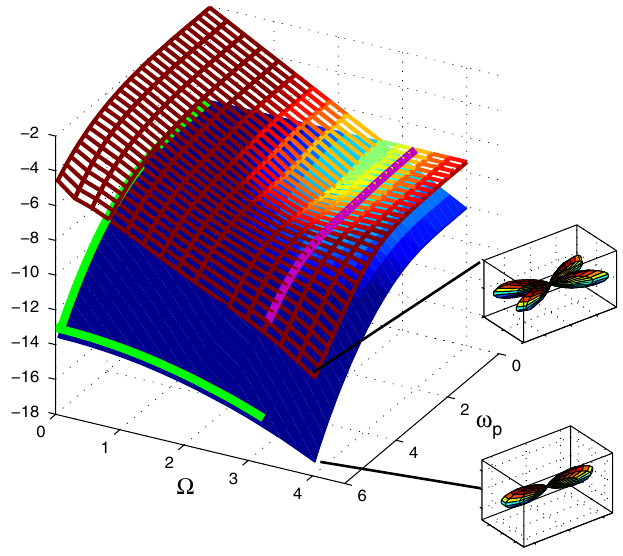
FIG. 5. Energy eignvalues of the rotating frame Hamiltonian, ffiffiffi q U H B , in the ( (cid:1) , ! ) parameter space. R Eq. (7), in units of p ¼ I , and the color of the curve The x and y axes are in units of B @ represents the splitting between the eignevalues. Also shown are the paths followed by the optical centrifuge [2] (green) and the method described here (magenta). The insets show j c j 2 for different points in the parameter